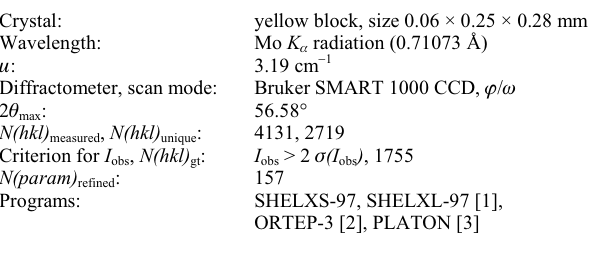
Table 1. Data collection and handling.